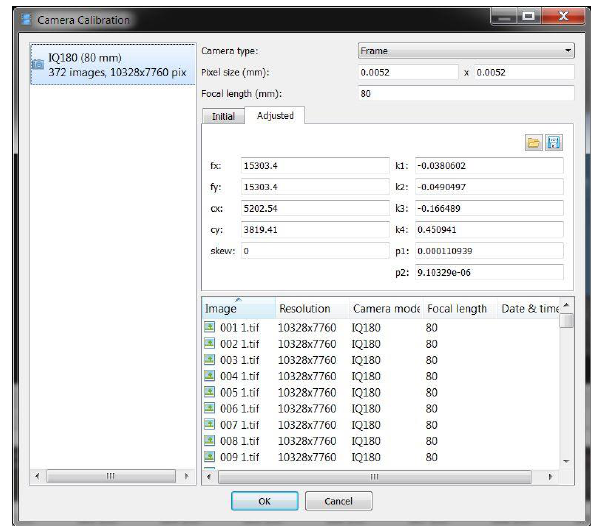
Figure 9. Calibration results for iXA